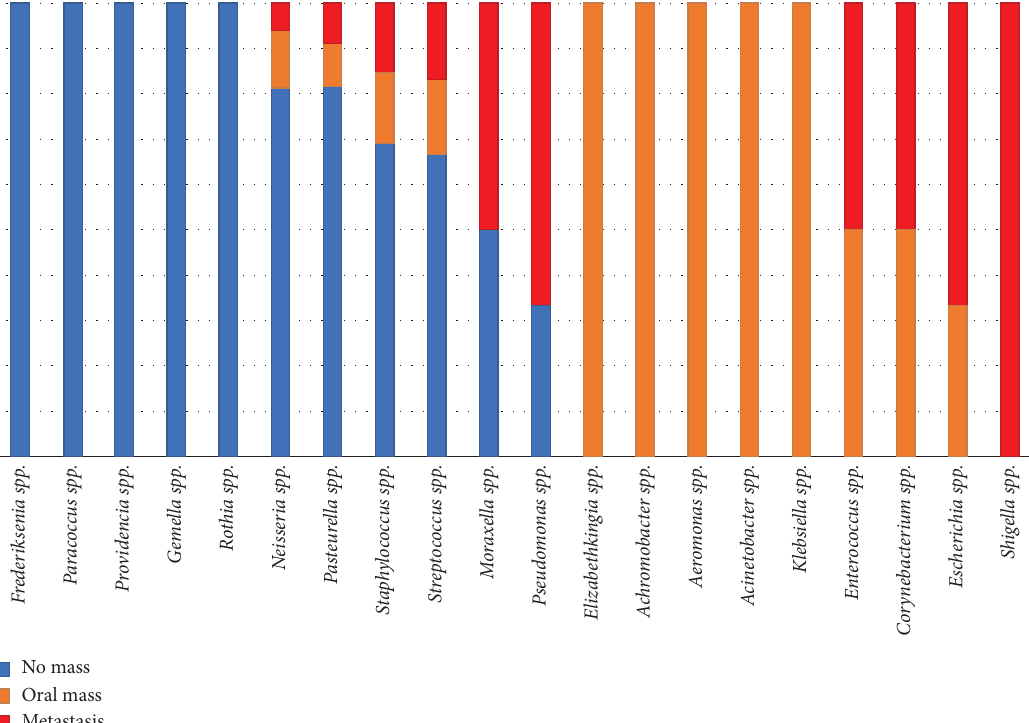
Figure 8: Genus of the bacterial isolates which were analyzed based on 16S rRNA gene taxonomy from the canine oral swabs in the three groups of